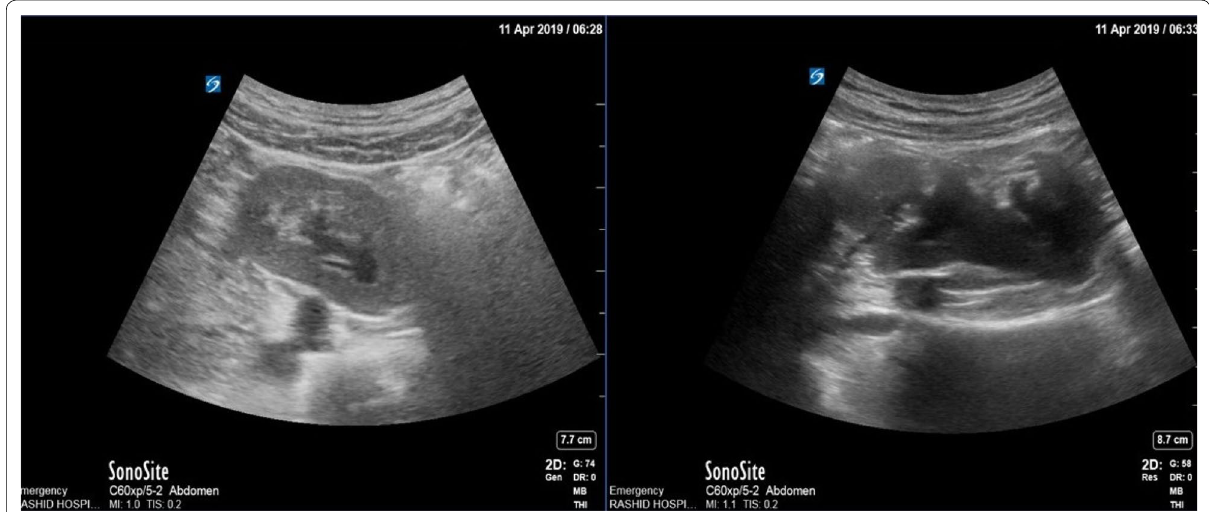
Fig. 2 Left side showing the transverse section through the right ectopic kidney and right side through the longitudinal section